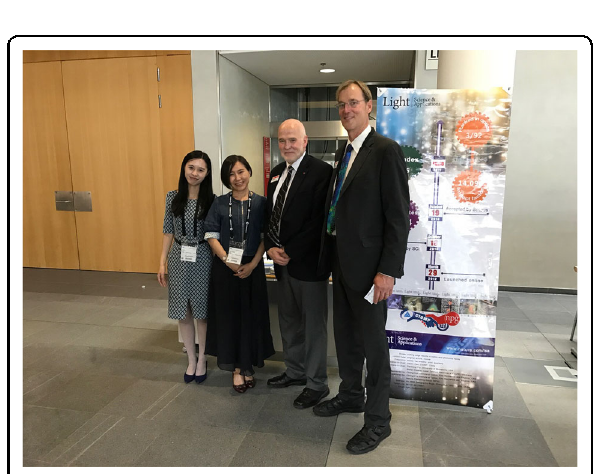
Fig. 4 Readers at LSA ’ s booth.